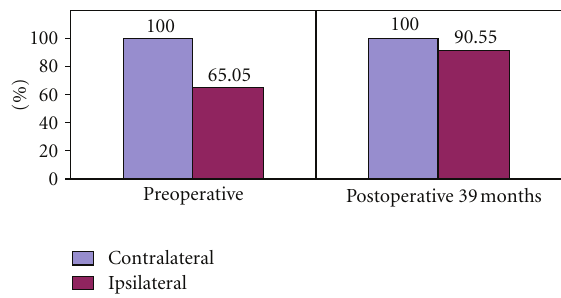
Figure 1: The e ff ect of varicocelectomy on ipsilateral testis develop- ment (mean contralateral testis volume was admitted as 100 units).